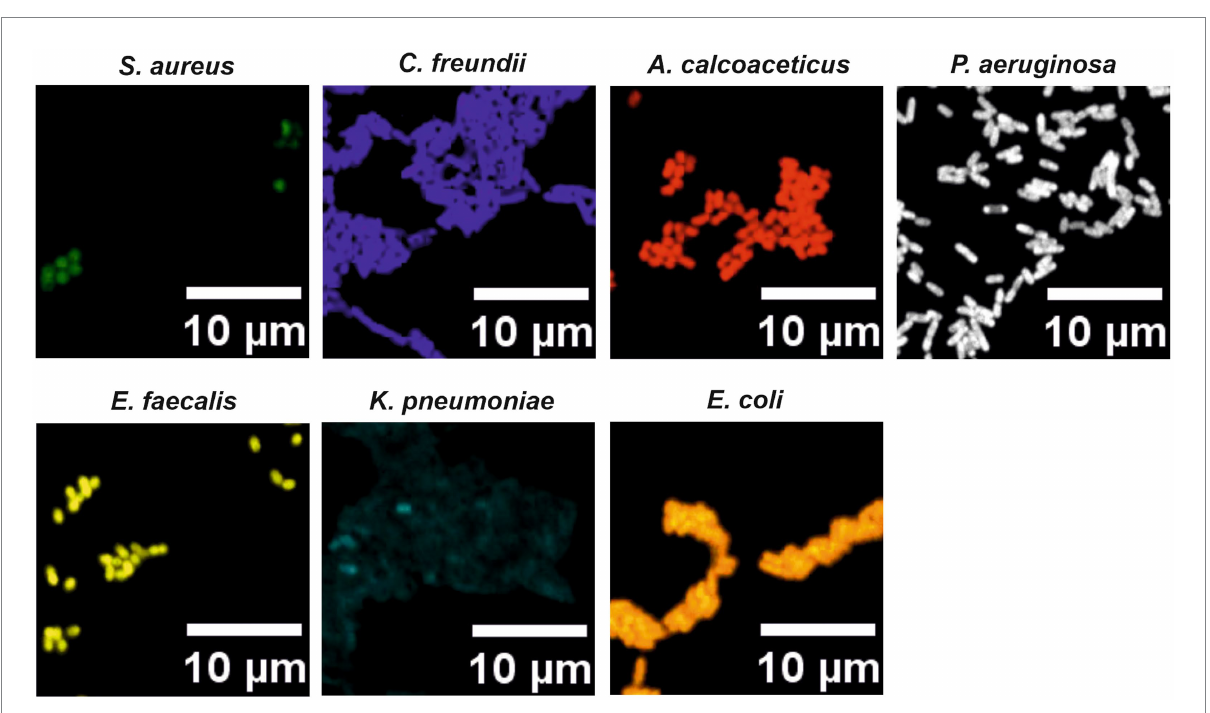
FIGURE 4 Hybridization results for the species-specific LNA/2’OMe probes with pure cultures smears. A range of hybridization temperatures, between 50 and 65 ° C, was tested to achieve the best FISH signals for a multiplex assay. The same hybridization conditions were used for all probes. The hybridization temperature selected for the multiplex experiments was 62 °